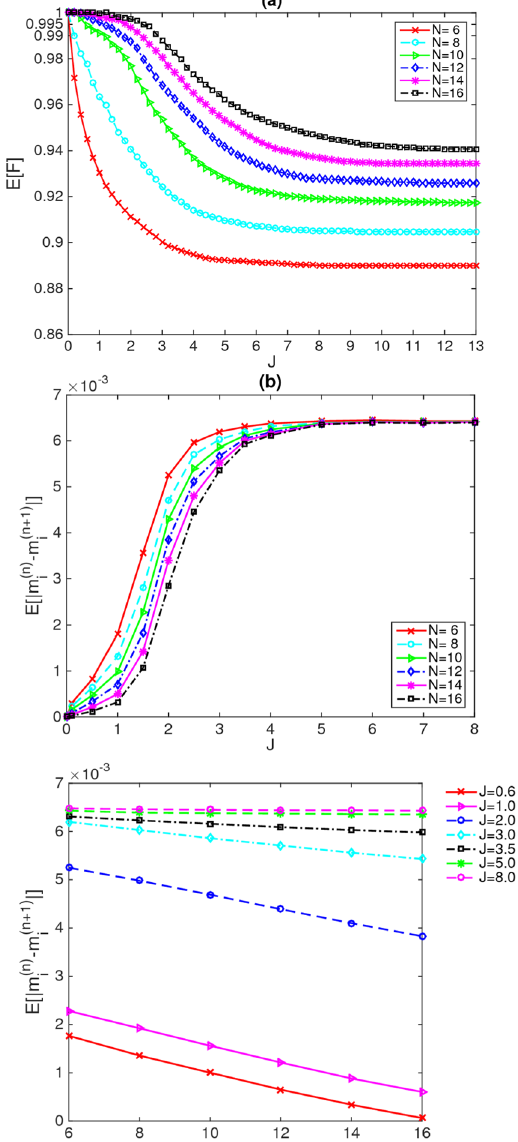
Figure 1. ( a ) Average fidelity as a function of the disorder strength J for system sizes from 6 to 16. The system sizes N are indicated in the legend. ( b ) Average difference as a function of the disorder strength J . ( c ) Average difference as a function of the system size N for different values of the disorder strength J . The values of J are indicated in the legend. In the ergodic phase (at small J ), where the eigenstates are thermal, these differences vanish exponentially in N as N increases, whereas they remain large in the localized phase (at large J